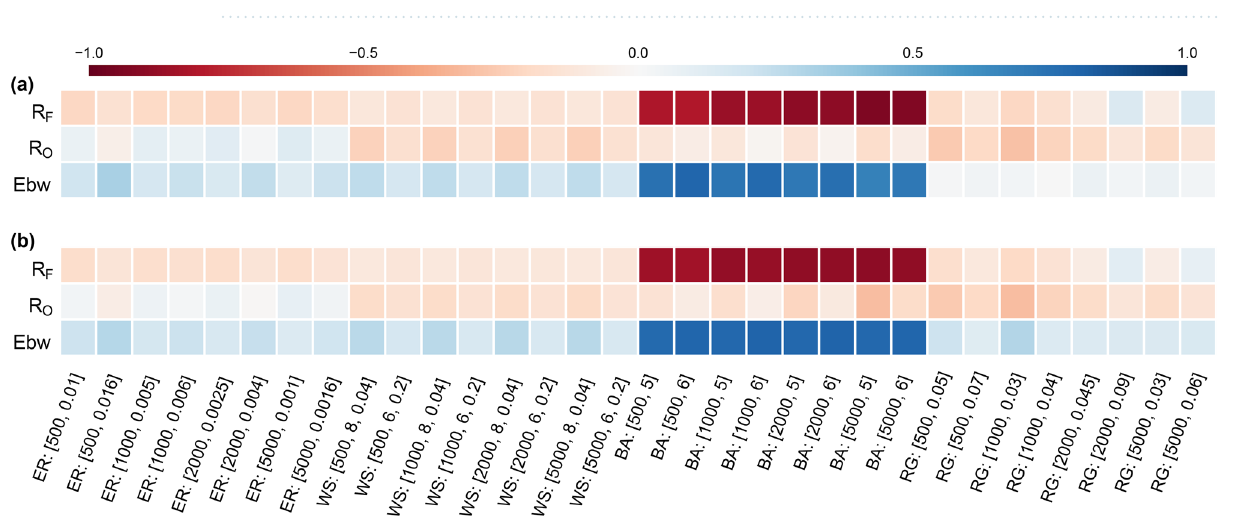
Figure 7. Correlation between degree difference (DD) and three established edge-based measures, namely, Forman–Ricci curvature ( R F ), Ollivier–Ricci curvature ( R O ), and edge betweenness centrality (Ebw) in synthetic networks. We show in ( a ) the Pearson correlation coefficients and in ( b ) the Spearman correlation coefficients. For each model, the parameters used are indicated besides it in parenthesis. For ER model, the parameters are number of vertices n and probability p of connecting an edge between any pair of vertices. For WS model, the parameters are number of vertices n , the number of neighbours k to which each vertex is connected in the starting regular graph, and rewiring probability β . For BA model, the parameters are number of vertices n and number of edges β that are attached to the new vertex at each iteration step. For RG model, the parameters are number of vertices n and radius ǫ . The reported correlation for each model and a given set of parameters is an average over a sample of 50